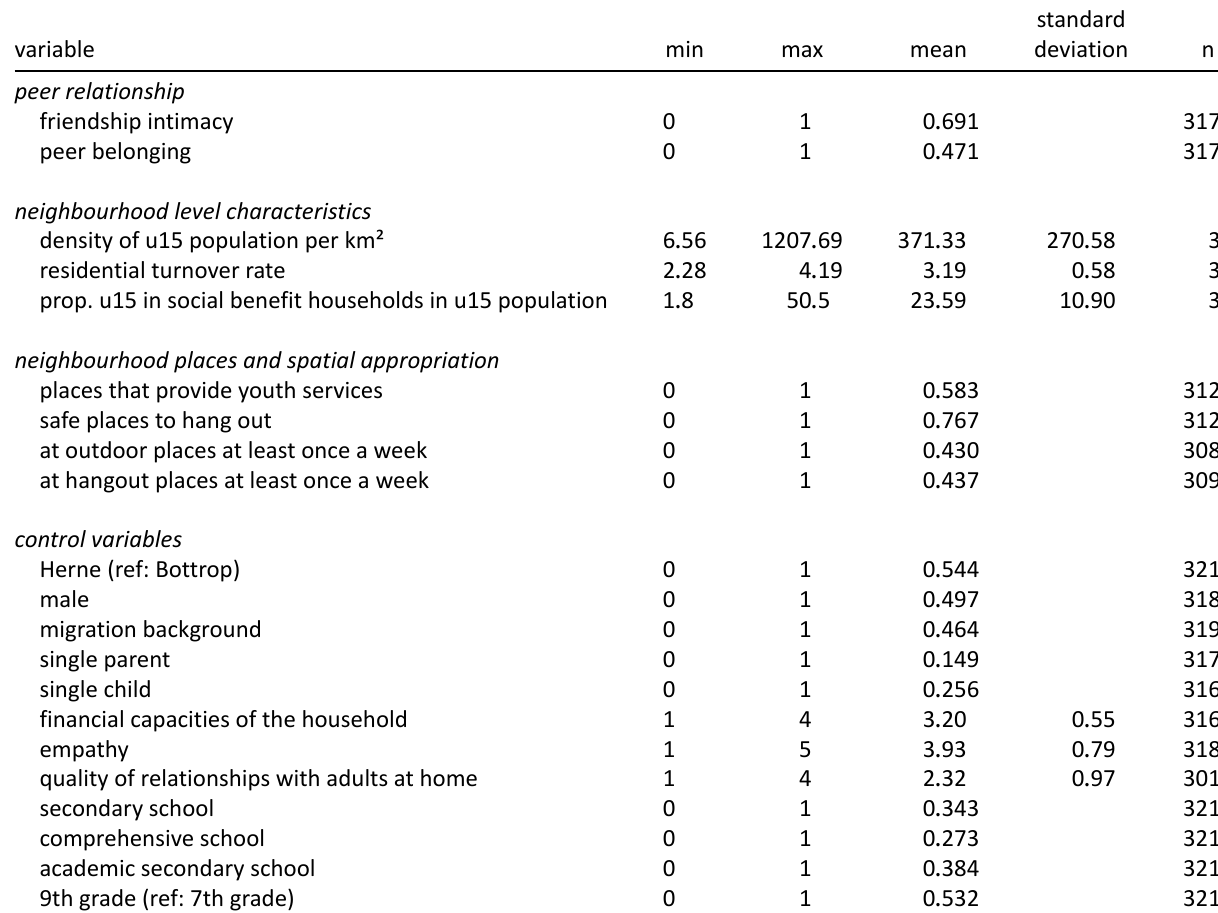
Table 1. Summary statistics of all